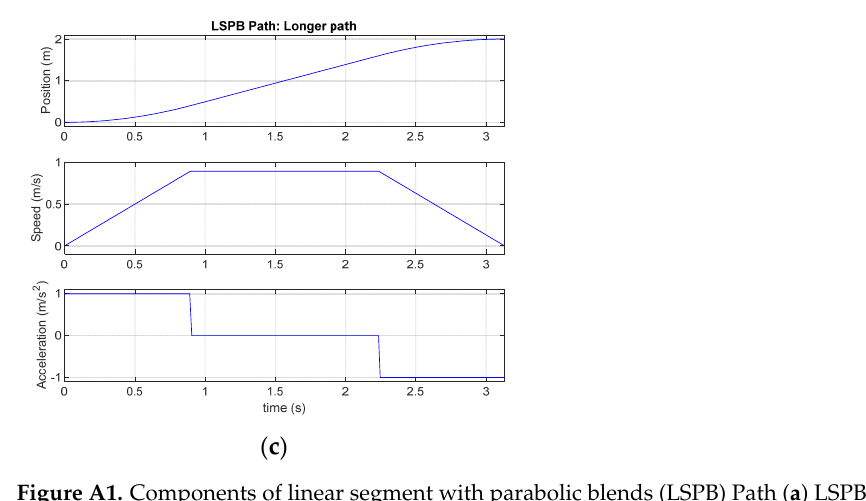
Figure A1. Components of linear segment with parabolic blends (LSPB) Path ( a ) LSPB total path ( b ) LSPB shorter path ( c ) LSPB longer path.